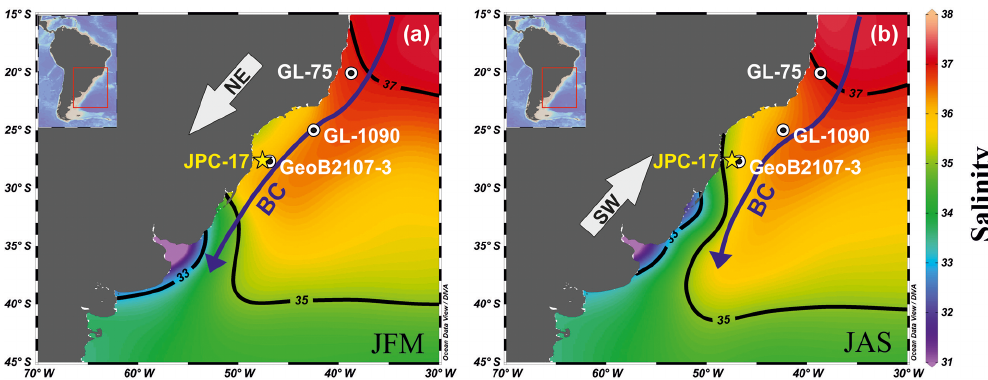
Figure 1. Surface salinity in the southwestern Atlantic Ocean (Locarnini et al., 2010) during (a) austral summer (December–February; DJF) and (b) winter (June–August; JJA) showing the location of cores JPC-17 (27 ◦ 53 (cid:48) S, 46 ◦ 55 (cid:48) W; this study), GeoB2107-3 (27 ◦ 17 (cid:48) S, 46 ◦ 45 (cid:48) W; Gu et al., 2017), GL-1090 (24 ◦ 92 (cid:48) S, 42 ◦ 51 (cid:48) W; Santos et al., 2017) and GL-75 (21 ◦ 9 (cid:48) S, 40 ◦ 1 (cid:48) W; Portilho-Ramos et al., 2015). Blue arrows indicate the western boundary Brazil Current (BC) and the gray arrows show the regional prevailing alongshore wind direction (northeast – NE and southwest – SW). The figure was created using the Ocean Data View software (ODV; version 4.7.10; https://odv.awi.de/, last access: 20 March